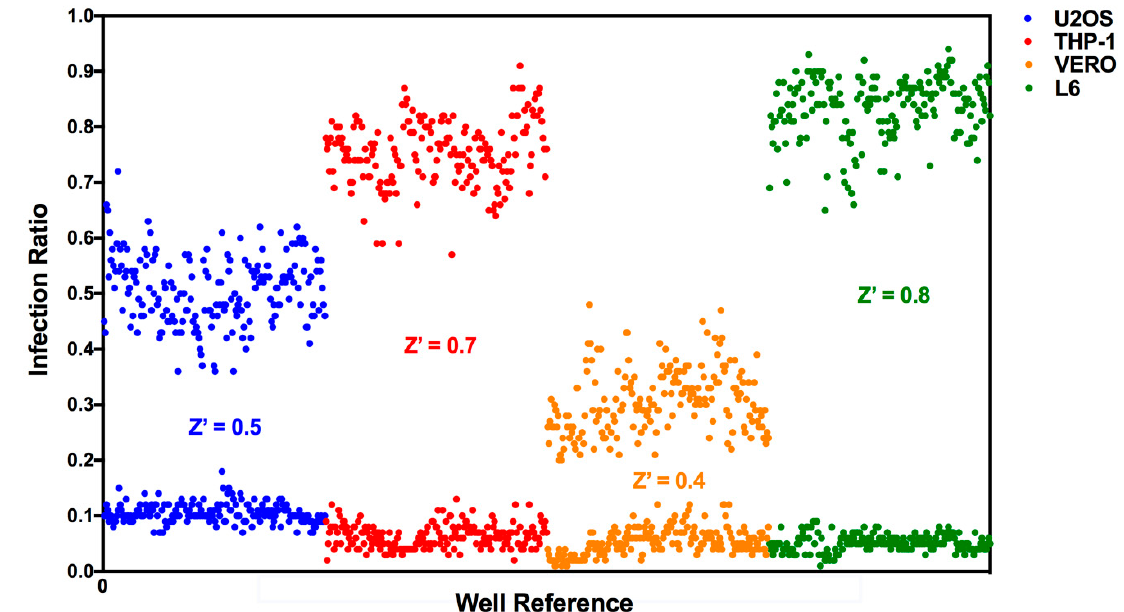
Figure 2. Screening assay performance depends on the host cell. Z’-factors and distribution of negative (DMSO-treated) and positive (non-infected) controls for LOPAC 1280 library screening using di ff erent host cell lines infected with T. cruzi Y-H10: U2OS (blue dots), THP-1 (red), Vero (orange) and L6 (green). X-axis: infection ratio values for each control well, Y-axis: well reference for assay plates. Data were plotted from controls of six assay plates (four library compound plates + two dose-response control plates).